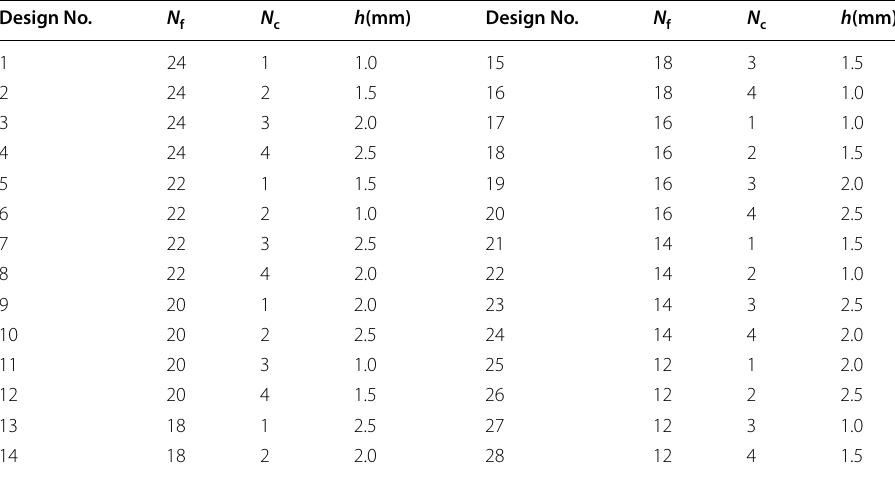
Table 3 The mixed-level orthogonal array for CFD simulations Design